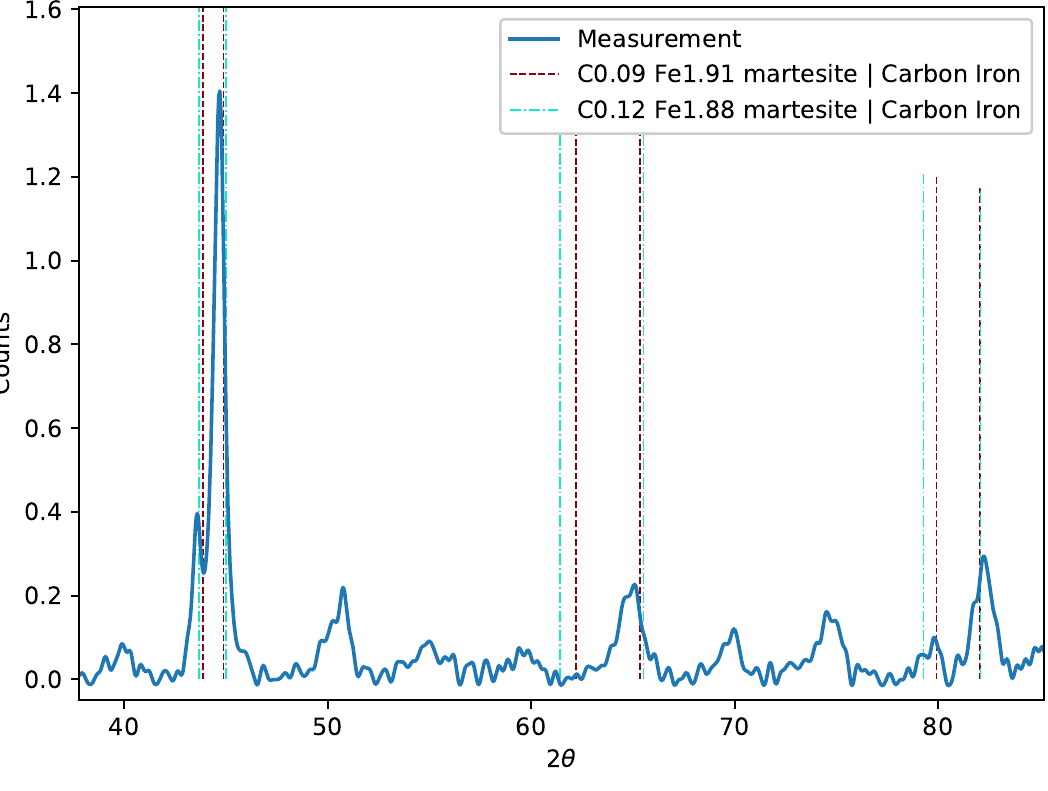
Figure 5. Intensity over 2 θ acquired via XRD measurements from additive manufactured H13 tool